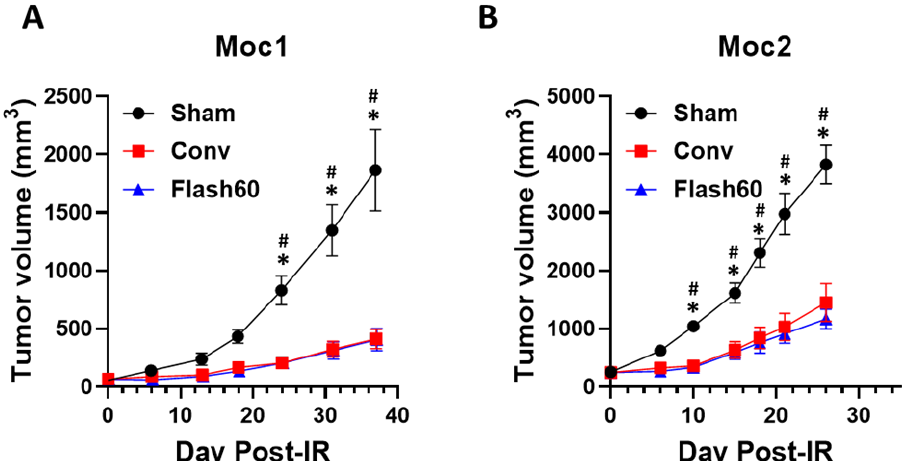
Figure 5. FLASH PBS and Conv irradiation induce equivalent control of indolent and aggressive squamous cell carcinomas. MOC1 (2 × 10 6 cells) or aggressive MOC2 (2 × 10 5 cells) murine squamous cell carcinoma cells were injected subcutaneously into the right flanks of C57Bl/6 immunocompetent mice ( n = 8/group). Twenty-one days post injection, the mice were randomized in groups of equivalent average tumor sizes. Tumors were irradiated with 15 Gy of Conv or FLASH PBS. ( A ) MOC1 and ( B ) MOC2 tumor volume measurements as a function of post irradiation time. Differences between conditions were determined by a two-way ANOVA test with multiple-comparison Tukey correction. Bars represent mean +/ − SD. * p ≤ 0.05 vs. Conv and # p ≤ 0.05 vs. Flash60.